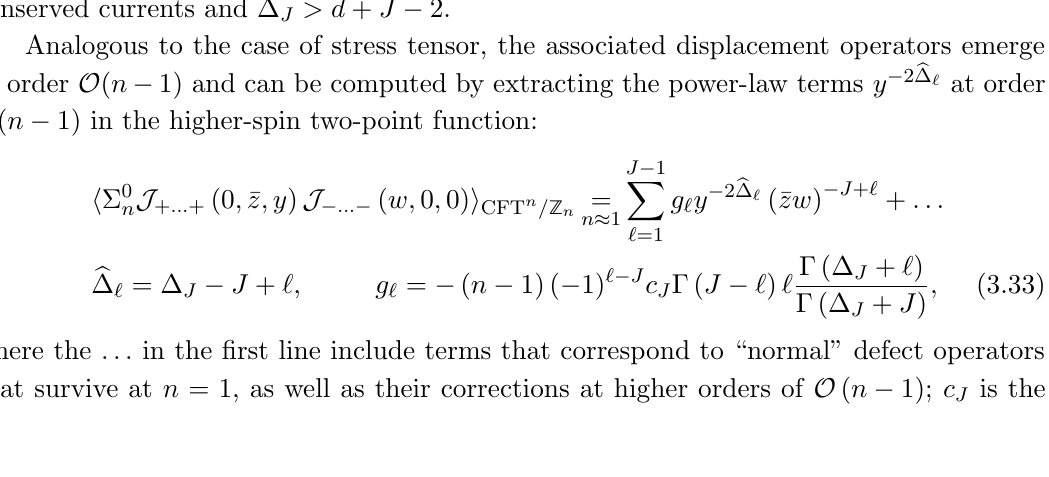
(1 ; 2). The 2 (cid:1) = d 1 = 2, (cid:0) b